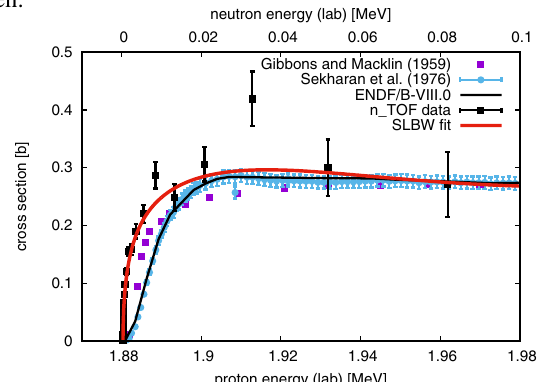
Figure 4. 7 Li(p,n) 7 Be cross section, near the 1.88 MeV thresh- old, derived from time reversal invariance applied to the n_TOF 7 Be(n,p) 7 Li data. Comparison is shown to the (p,n) measure- ments of Gibbons and Macklin [12] and Sekharan et al. [13] and to evaluated data file ENDF / B-VIII.0 [14]. The single-level Breit-Wigner cross section, calculated with the resonance param- eters provided in [4], is plotted as